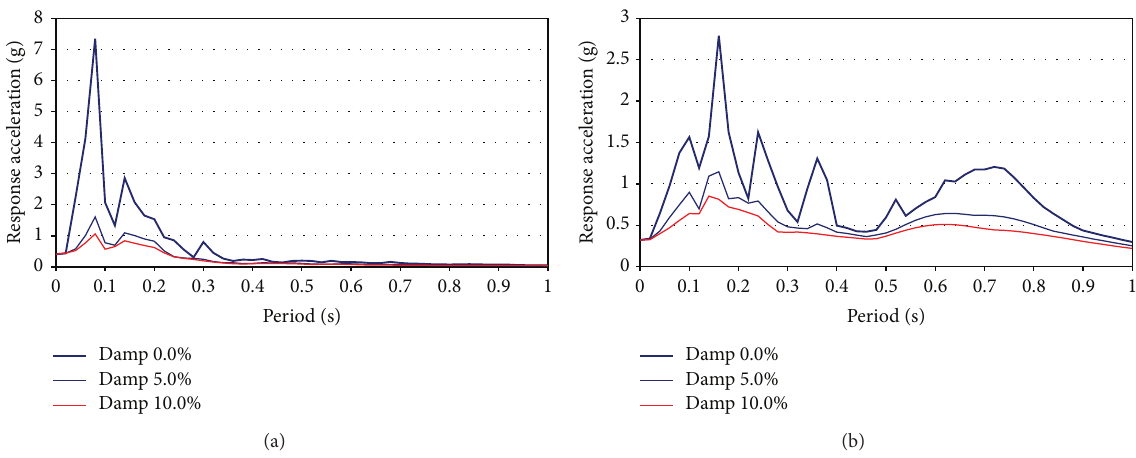
Figure 5: Elastic response spectrum of (a) LOMA P1 (FF) and (b) LOMA P2 (NF)